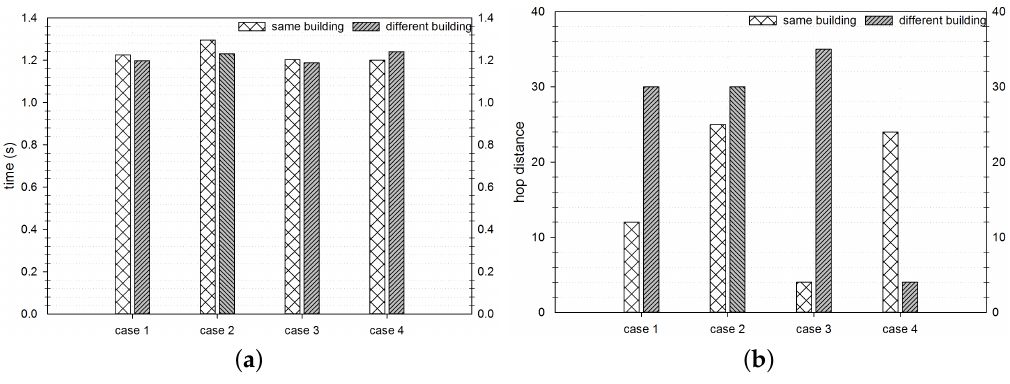
Figure 18. Performance of the path between two cells in four cases in a low density environment. ( a ) Response time performance; ( b ) the distance of hops in same and different